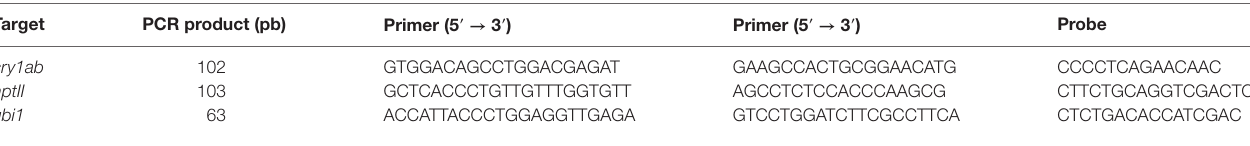
TaBle 2 | Primers and probes sequences used to identify exogenous ( cry1Ab and nptII ) and endogenous ( ubi ) genes present in CTC175-A by qPCR.